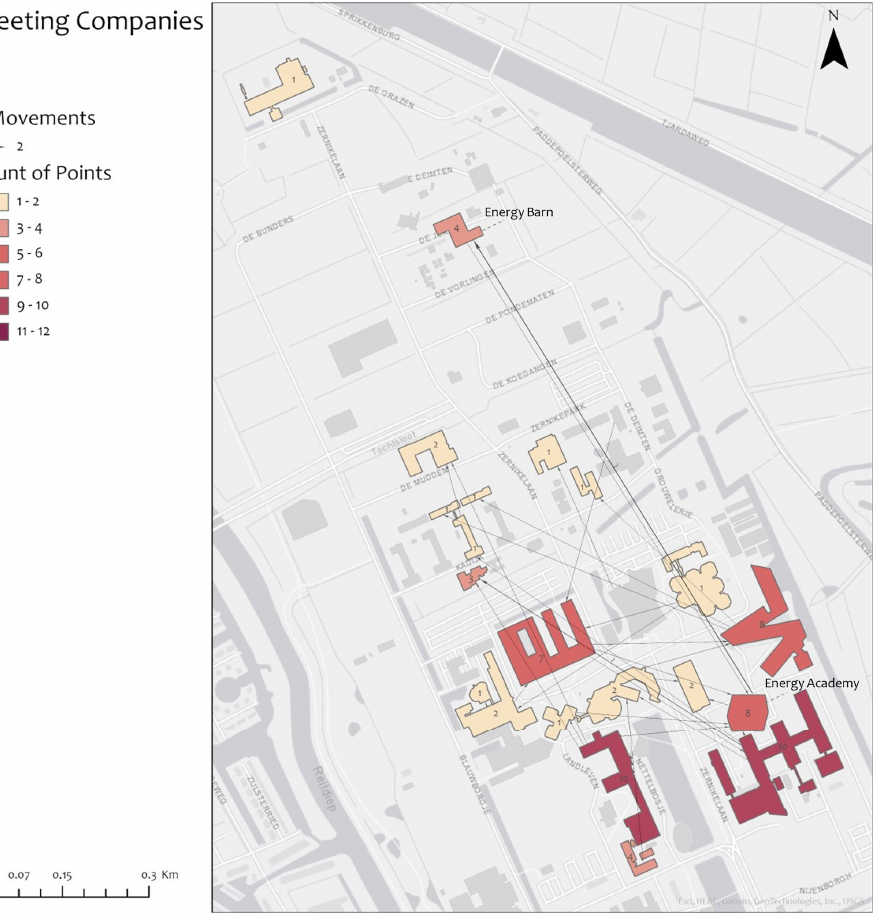
Figure A6. RUG campus—meetings with companies and movement across campus. # = ‘Number of’.